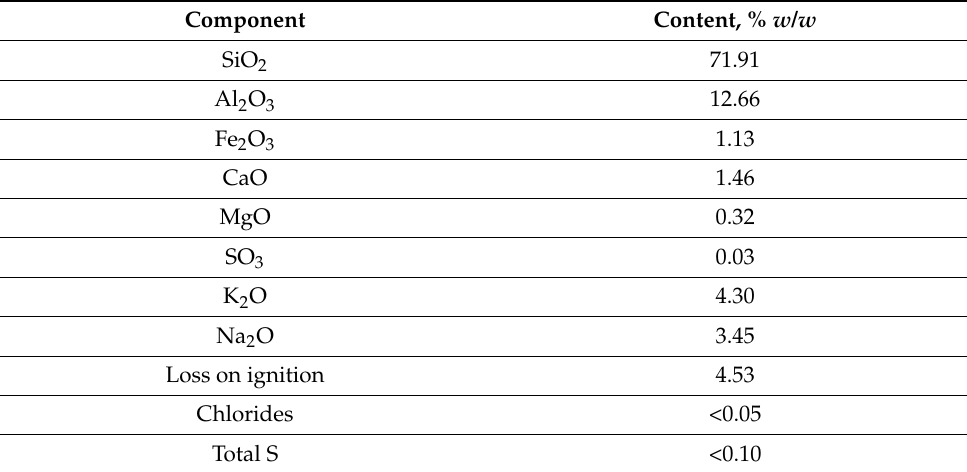
Table 2. Typical chemical analysis of pumice.